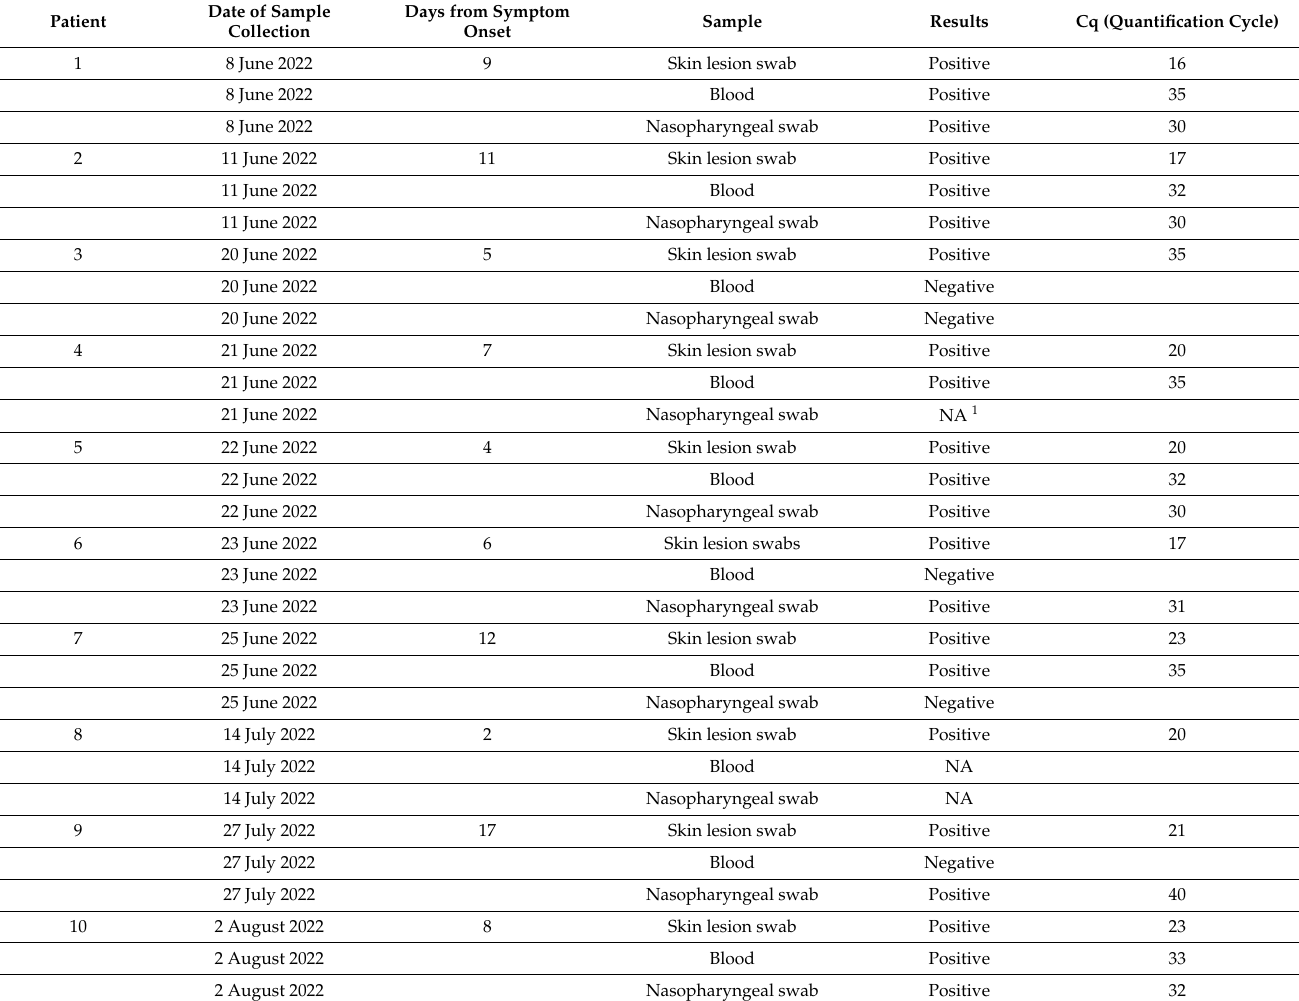
Table 2. Characteristics of clinical samples of patients in the Apulia region (Southern Italy) with